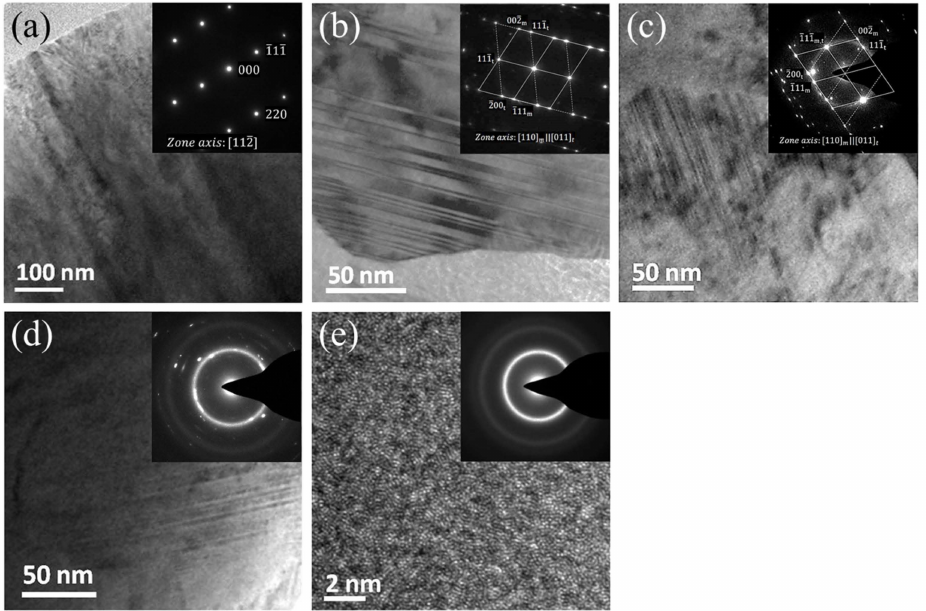
Figure 3. Cross-section bright field TEM images and the corresponding SAED patterns of the Nb x -CoCrFeMnNi HEAFs with the Nb concentrations of ( a ) 0, ( b ) 0.6, ( c ) 1.8, ( d ) 4.1, and ( e ) 7.2 at.%. (m: matrix, t: twin).